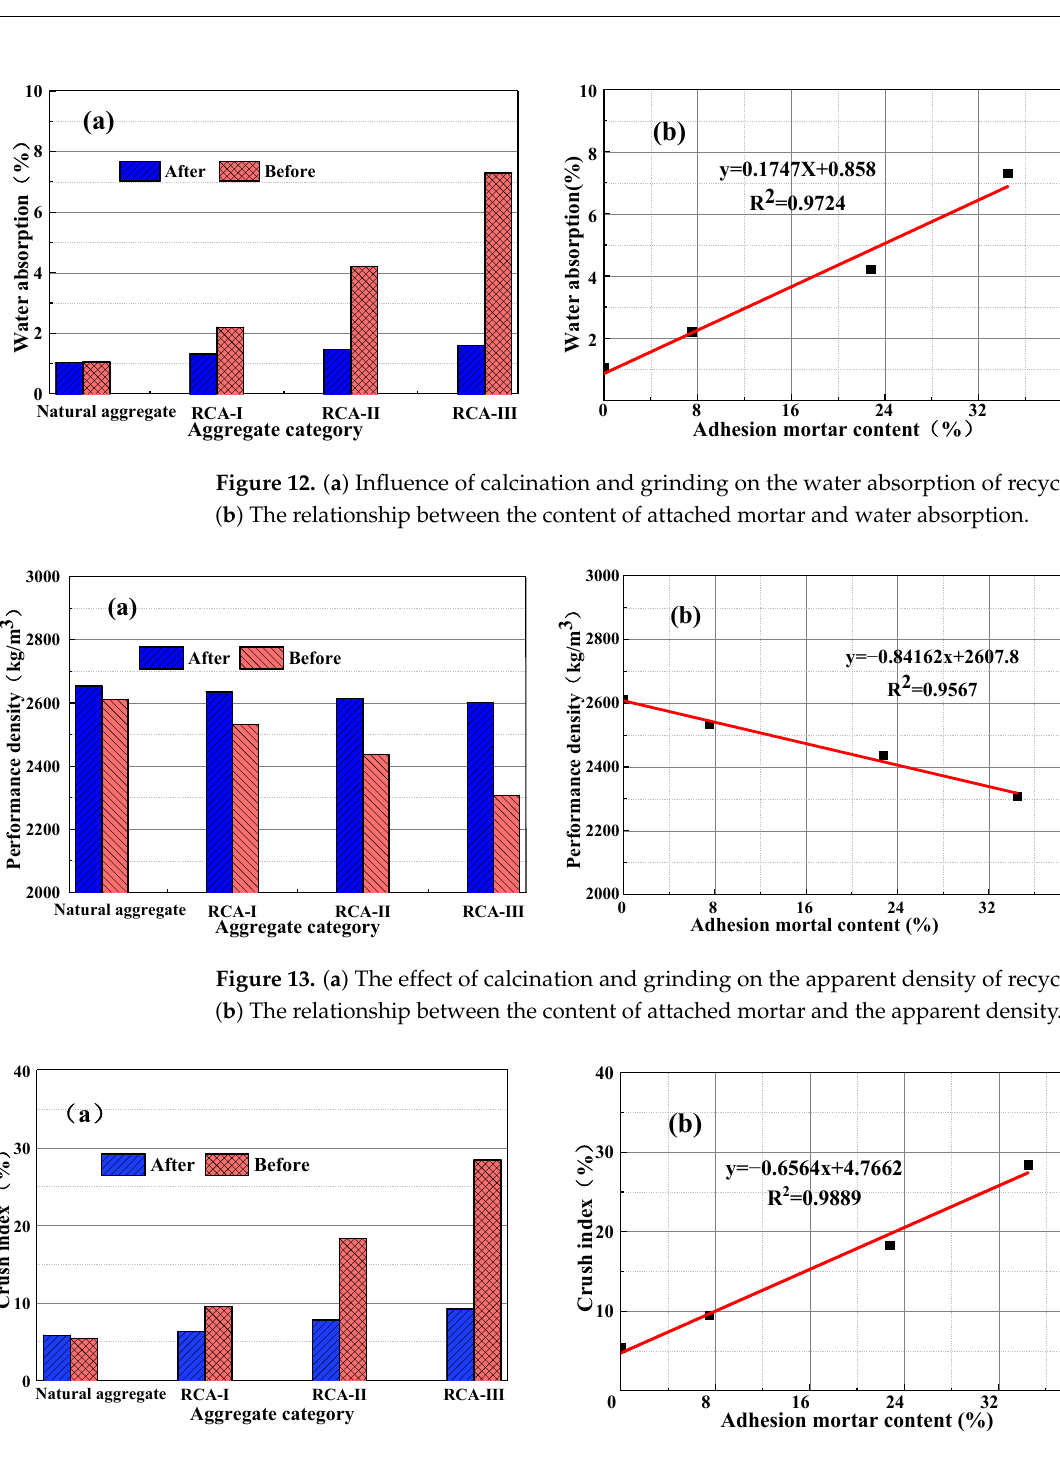
Figure 14. ( a ) Influence of calcination and grinding on the crushing index of recycled aggregate. ( b ) Relationship between the content of attached mortar and crushing